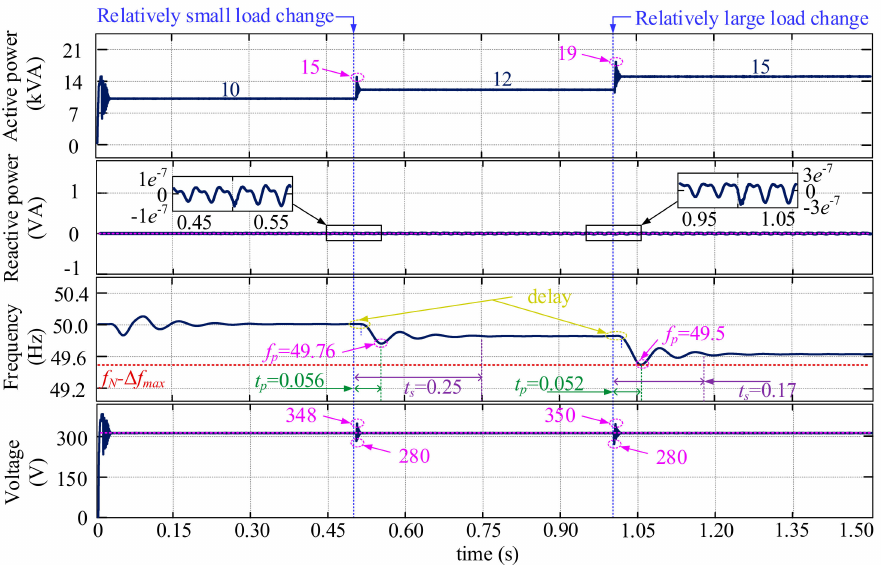
Figure 11. Simulation results of the traditional droop control strategy under di ff erent penetration levels of load